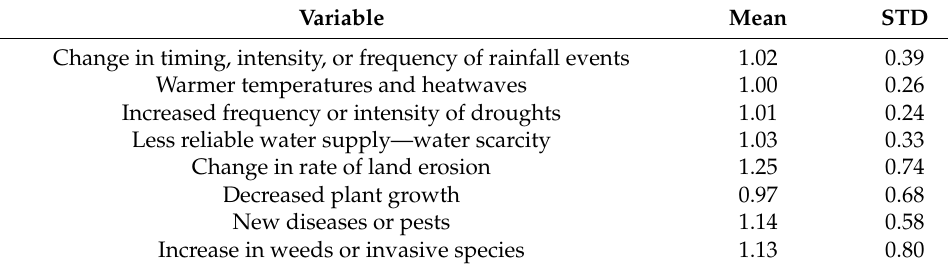
Table 5. Descriptive statistics of climate change perceived